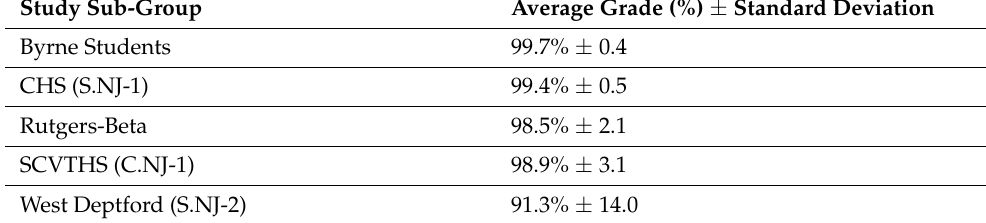
Table 2. Overall